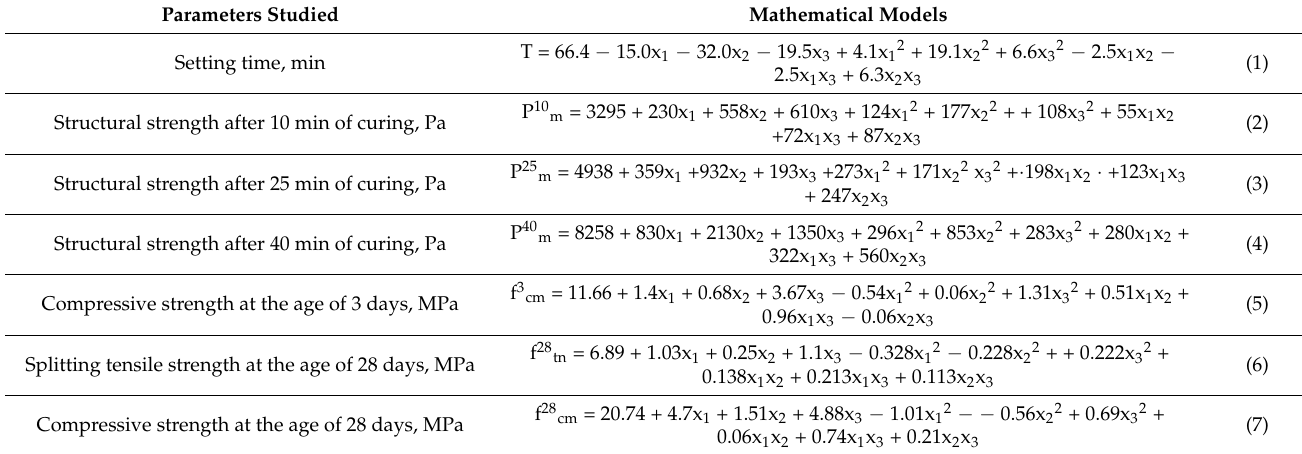
Table 5. Mathematical models of the properties of extruded concrete mixture and